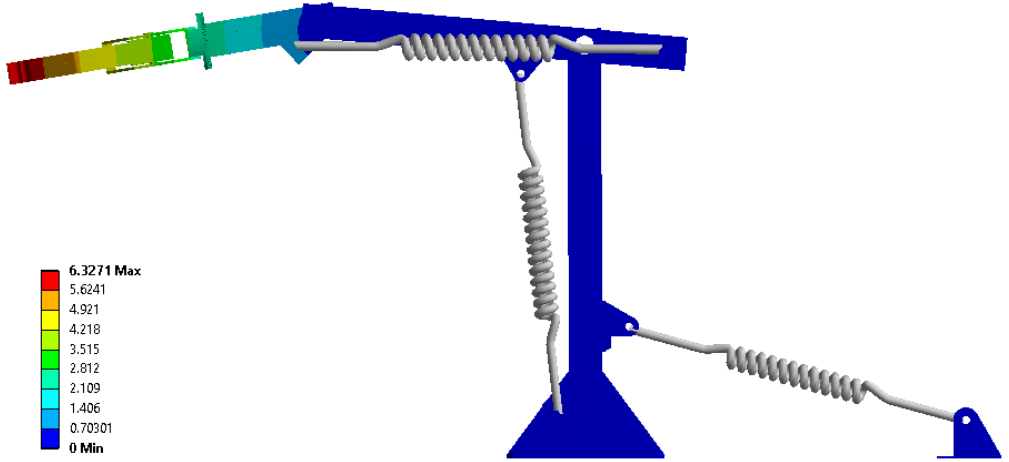
Figure 16. The resulting displacement field for configuration 3 and a force of 15 N.